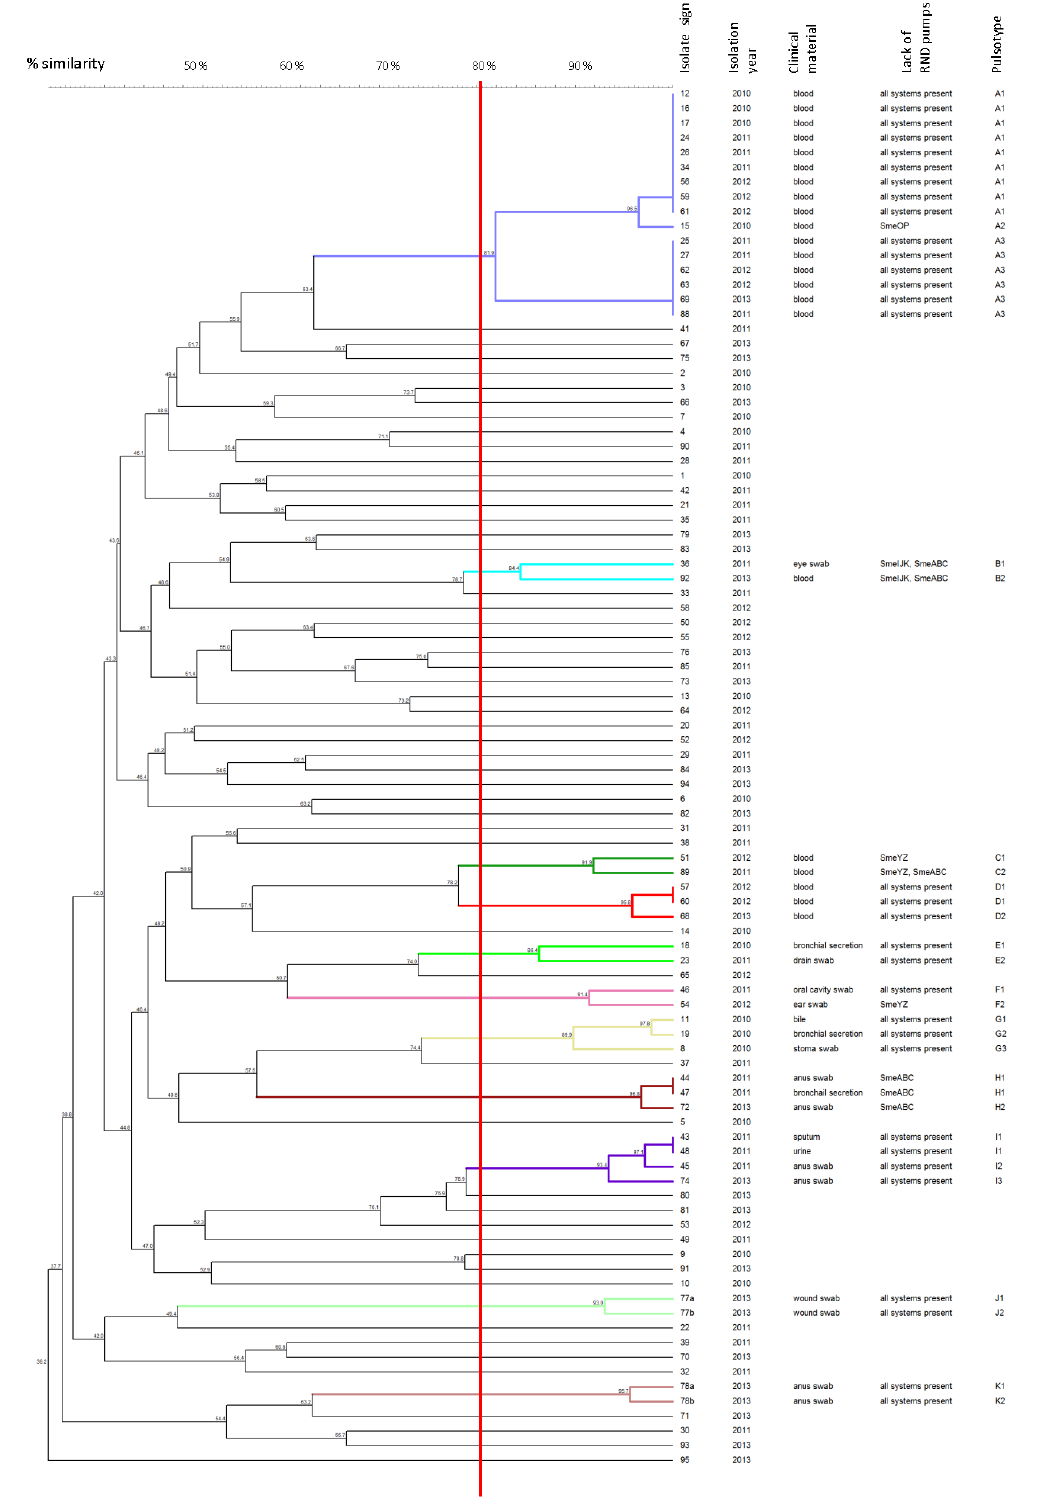
Figure 1. Analysis of PFGE patterns of the S. maltophilia isolates. The dendrogram presents the percentage similarity of PFGE profiles, the isolation year, the pulsotype mapped to clusters, and the following data about the named PTs: specified absence of the RND efflux systems and clinical material of isolation. The solid line indicates 80% similarity and is used to define the clusters with appropriate PTs. Isolates mapped to different clusters are marked with the various colors. In contrast, isolates not grouped in clusters are marked in